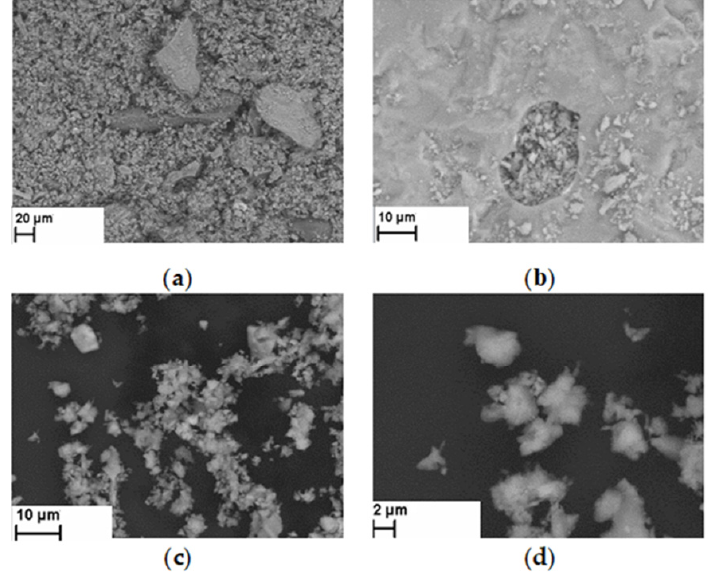
Figure 3. SEM micrographs of powdered poultry ash at di ff erent magnifications: ( a ) 500 × , ( b ) 2,000 × , ( c ) 20,000 × , and ( d ) 50,000 ×